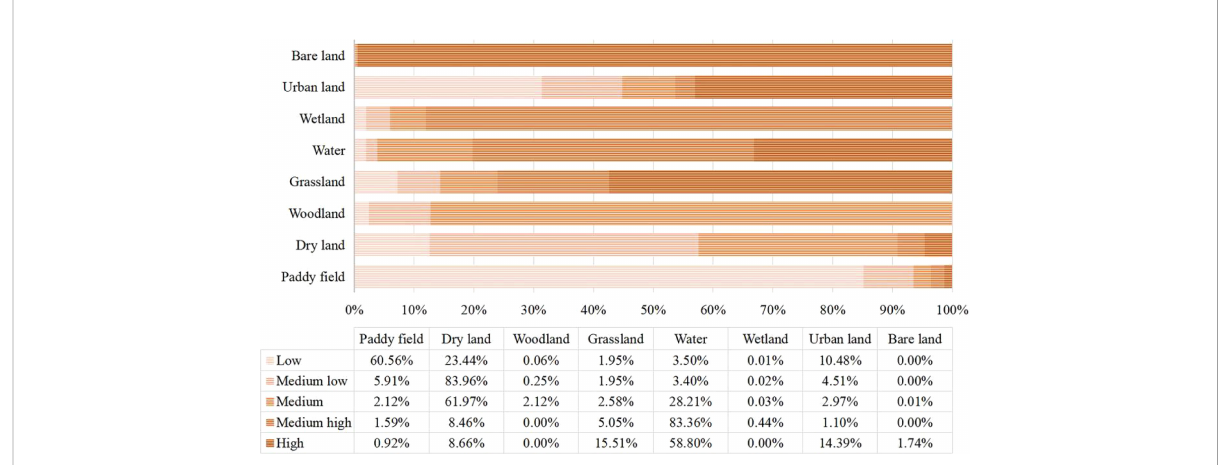
FIGURE 7 The proportion of each type of landscape at various risk levels.